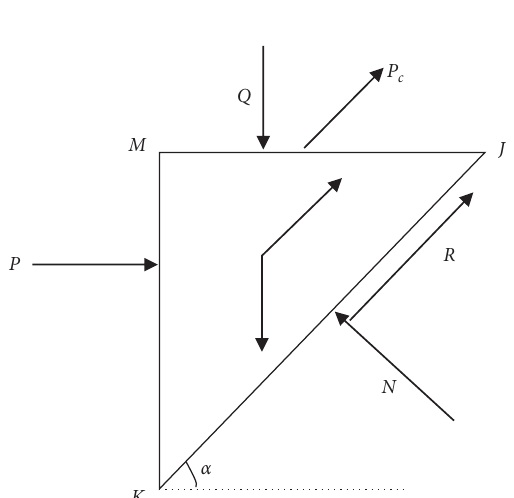
Figure 4: Loading analysis of the instability model.